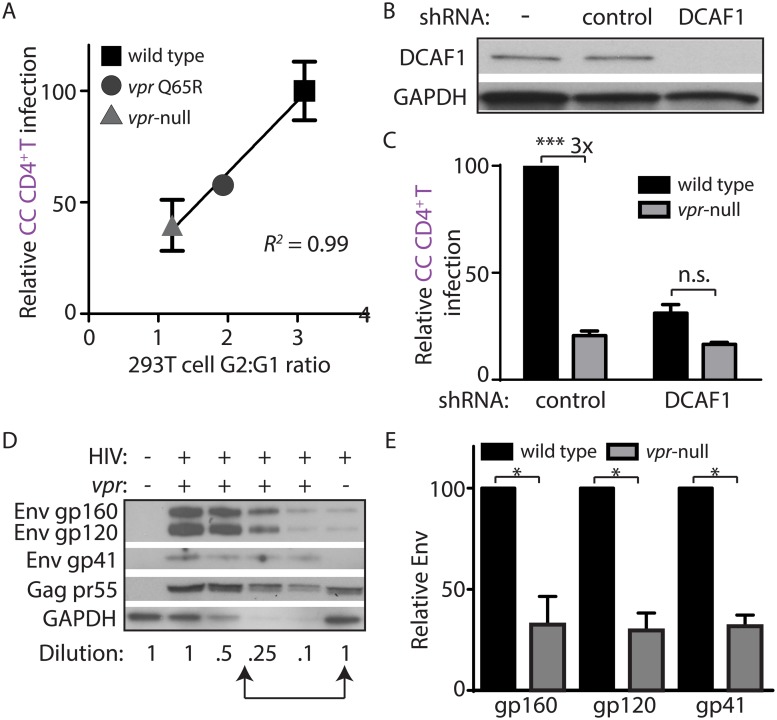
DCAF1 is required for Vpr-dependent HIV-1 spread from macrophages to CD4+ T lymphocytes.(A) Scatter-plot of Vpr-dependent cell cycle arrest in 293T cells (x-axis) versus relative infection frequency of CD4+ T lymphocytes co-cultured (“CC”) with infected MDM as outlined in Fig 2A. Infection frequency was assessed by flow cytometry and was normalized to that of wild type (y-axis). Best-fit curve from linear regression analysis, R
2 = 0.99 (n = 4 donors). (B) Immunoblot of DCAF1 and GAPDH in MDM seven days after transduction with lentivirus encoding shRNA targeting luciferase (“control”) or DCAF1. (C) Summary graph showing relative infection frequency of T lymphocytes co-cultured (“CC” as in Fig 2A) with MDM that had been treated with the indicated shRNA and infected with the indicated HIV-1 89.6 (n = 3 donors). (D) Immunoblot of HIV-1 89.6 Env and Gag in MDM-T lymphocyte co-culture whole-cell lysates diluted as indicated. Arrows denote lysates with comparable levels of Gag pr55 in the presence and absence of Vpr. (E) Summary graph of relative Env levels quantified by densitometry and normalized to Gag pr55 levels and to wild type (n = 4 donors). Error bars represent SEM. *p<0.05, ***p<0.001, “n.s.”p>0.05, student’s paired t-test.